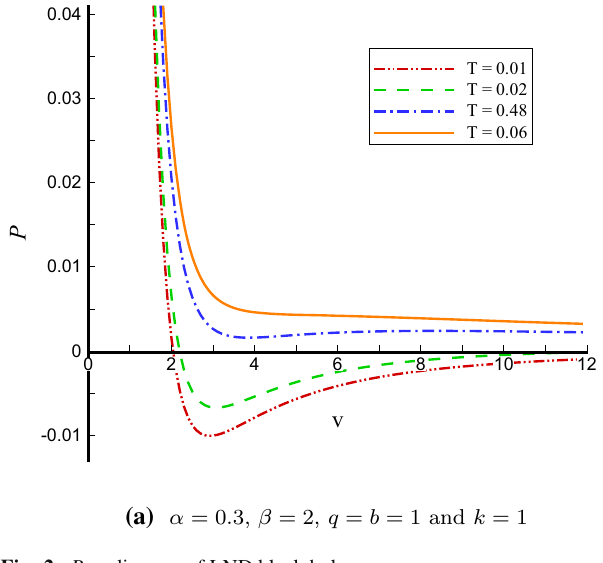
Fig. 2 P – v diagram of LND black